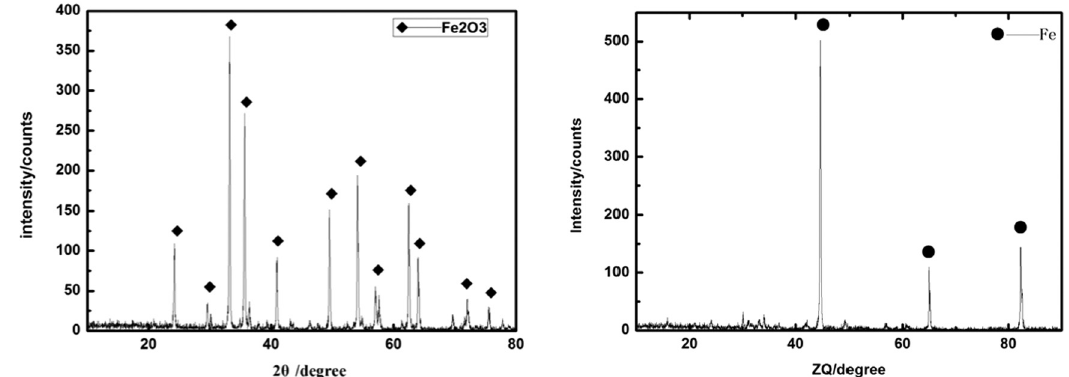
Figure 8: XRD spectra of iron ore briquettes before and after reduction. The left - hand image shows the briquette specimens before reduction, and the right - hand image shows the briquette after